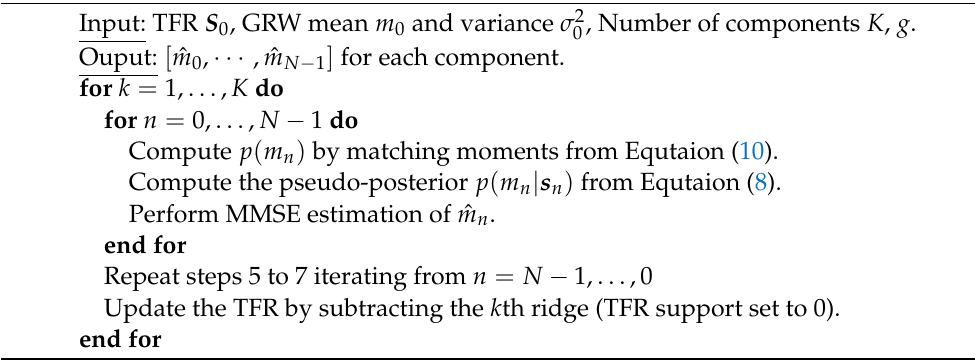
Algorithm 1: Overall ridge extraction procedure using backward